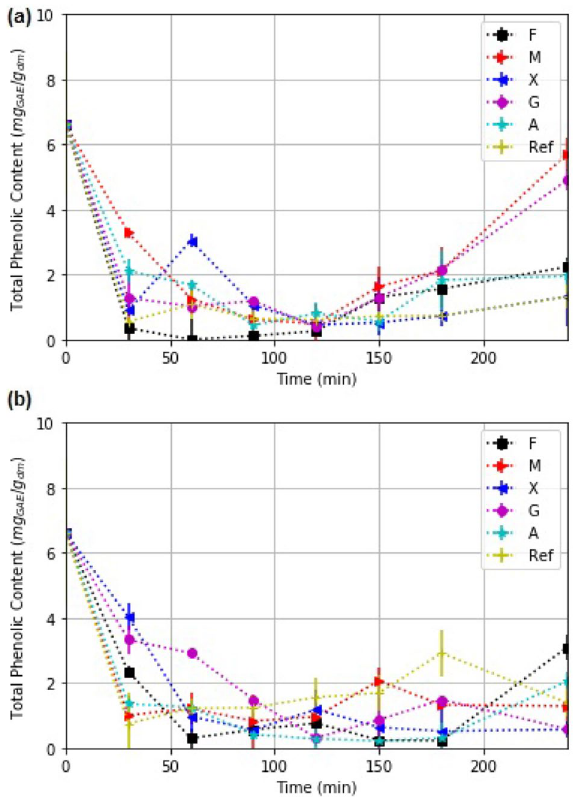
Figure 10. Kinetics of total phenolic compounds in strawberry slices with edible coatings and without it (Ref), studied for ( a ) solar drying, and ( b )